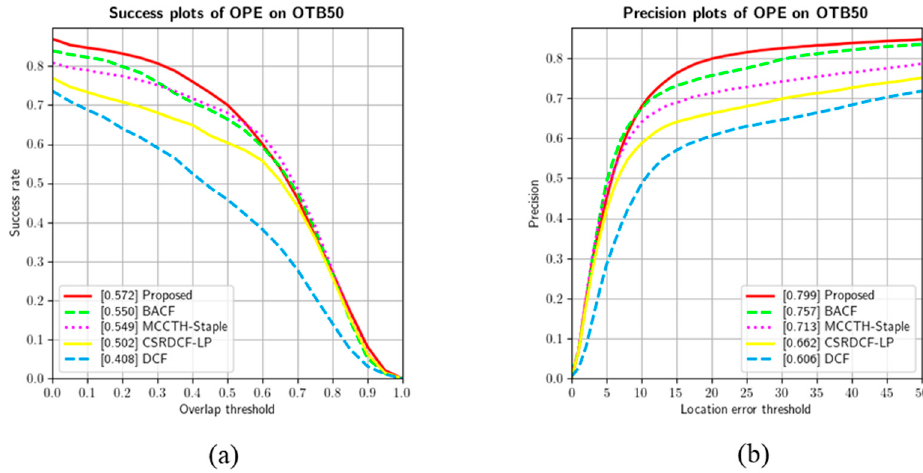
Figure 13. Evaluation Graph of OTB-50 for All Attributes ( a ) Success Plots Graph of OTB-50, ( b ) Precision Plots Graph of OTB-50. Table 4. Overall Performance Evaluation Results of OTB-50.